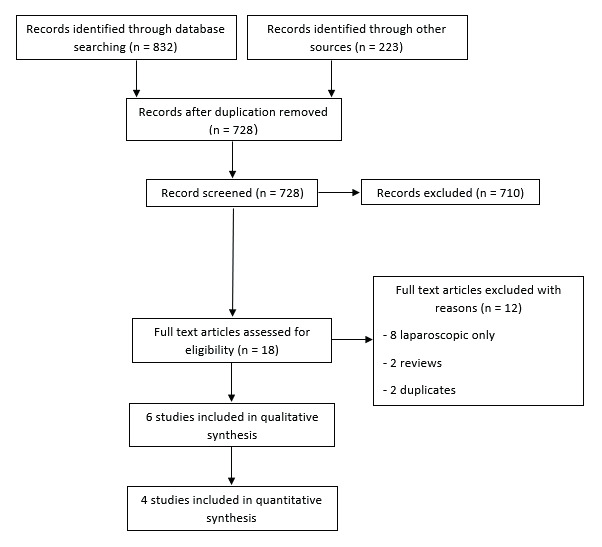
PRISMA flow chart